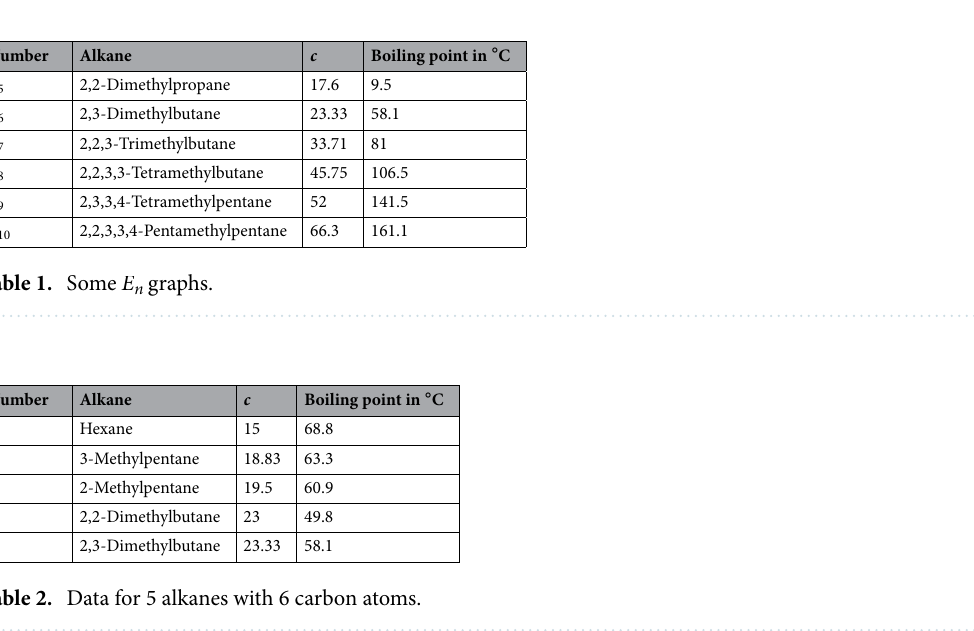
Figure 1. Molecular graph for the alkane, 2,2,3,3-tetramethylbutane.